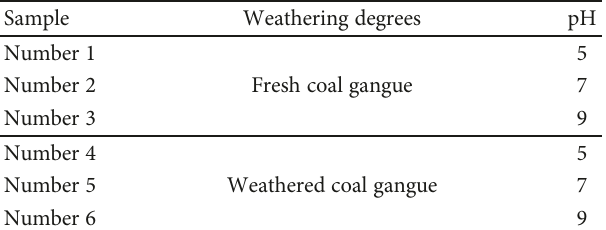
Table 3: Experimental design.